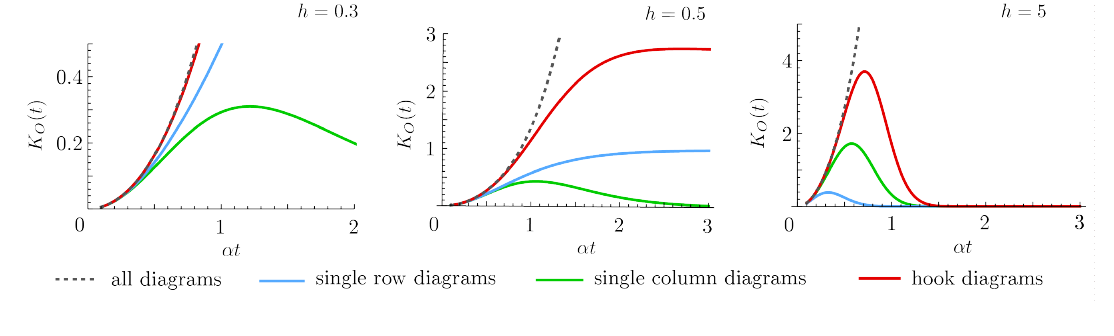
Figure 7 . Plots of